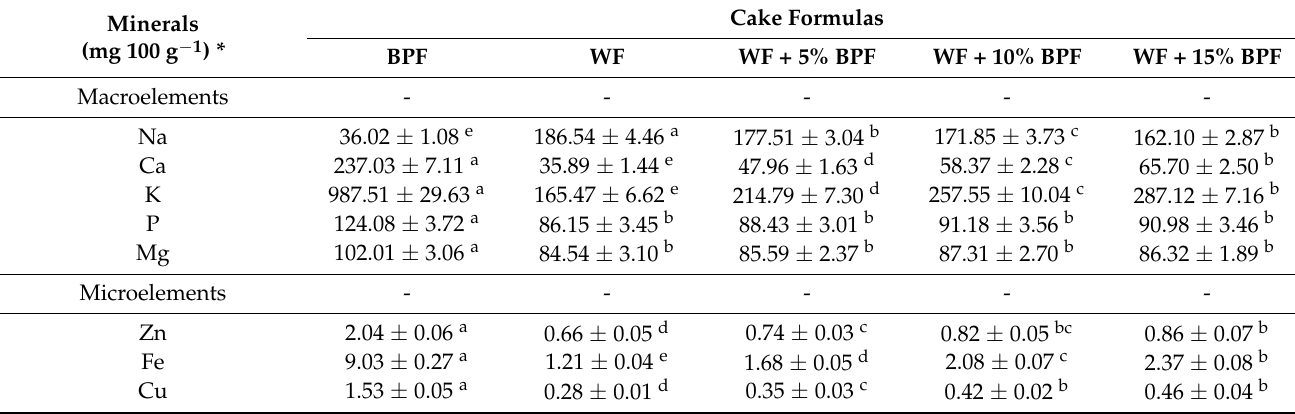
Table 3. Mineral content of WF and various substituted WF with BPF ( A. digitate